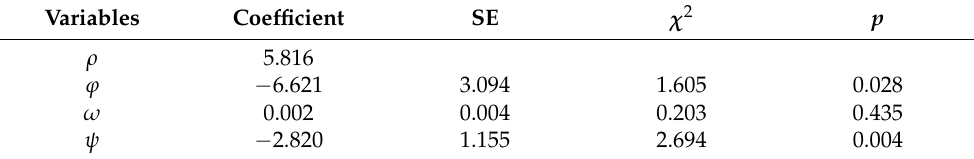
Table 1. Number of sites and surveys of the faecal pellet count in each prefecture.